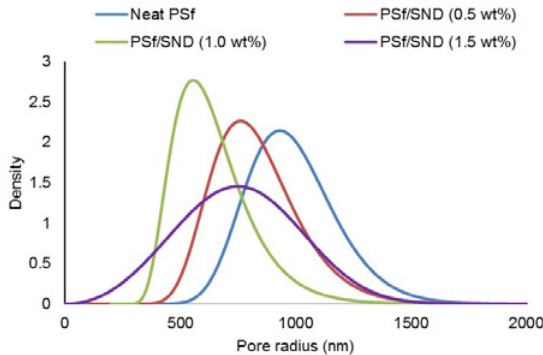
Fig. 3. The pore size distribution of membranes.